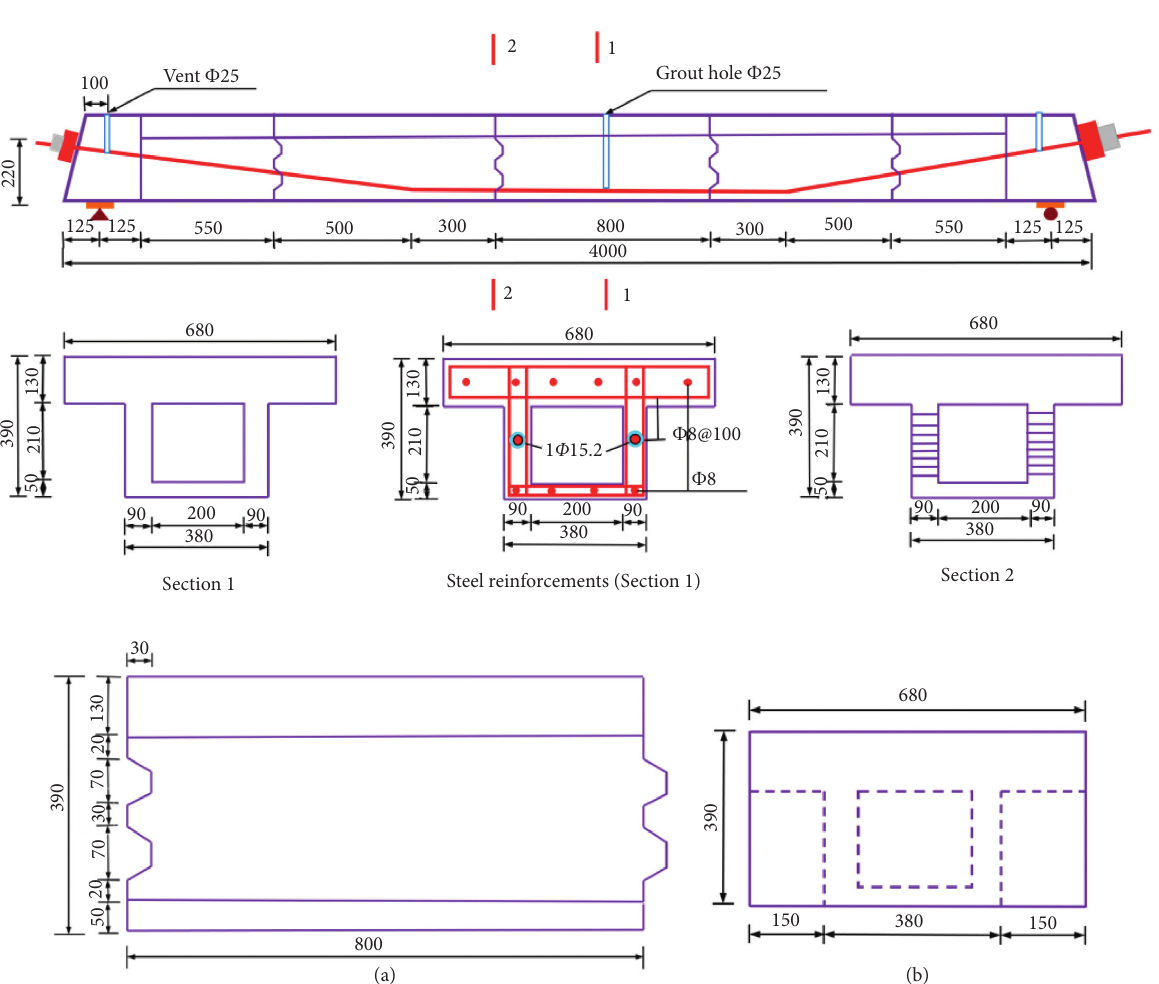
Figure 1: Specimen 1 (dimension unit: mm) [21]: (a) profile of a segment; (b) section at support.